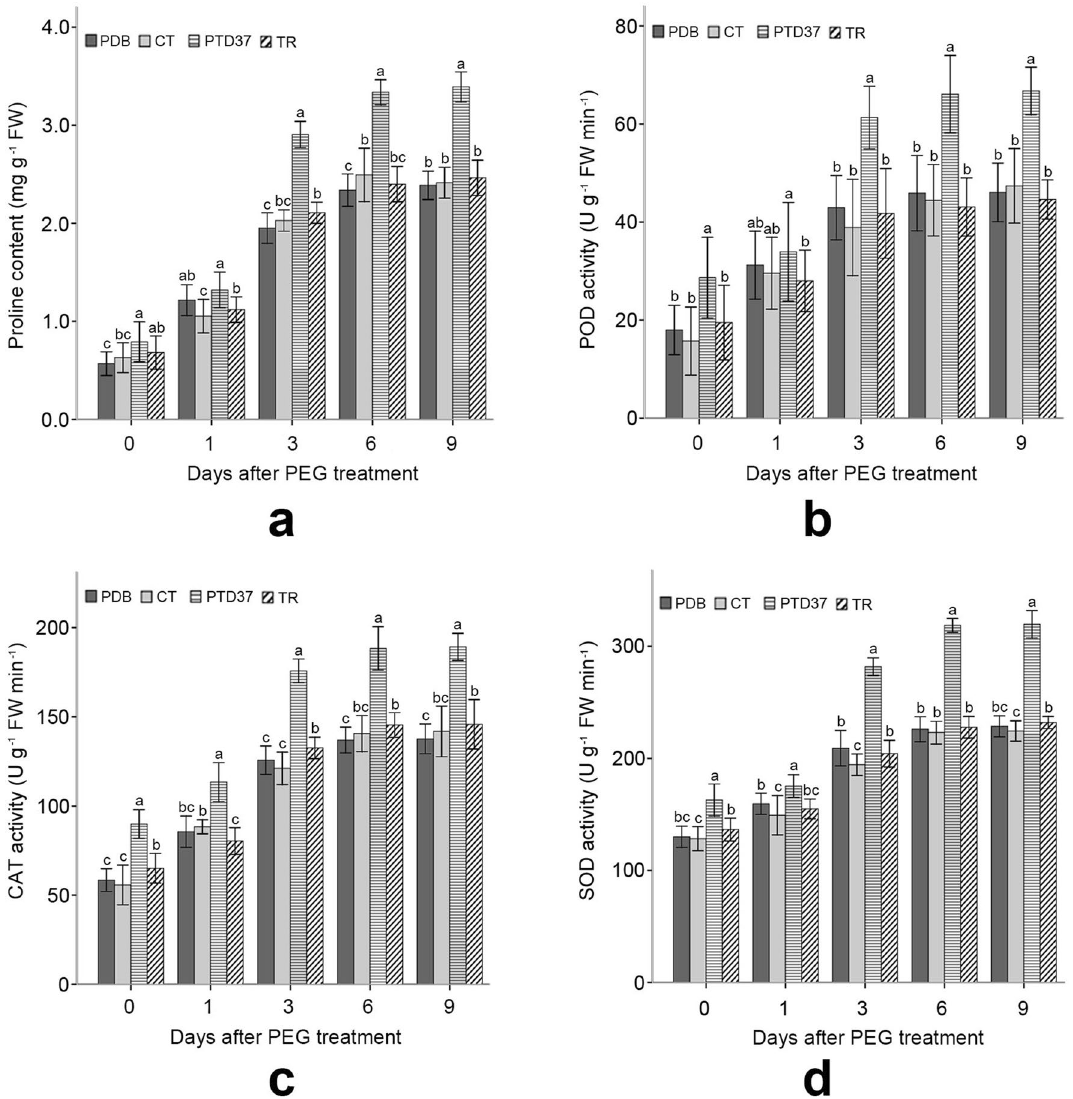
Figure 3. Effect of different treatments on the proline content and POD, CAT and SOD activities of seedling leaves before and after PEG application. ( a ) Effect of PEG application on the leaf proline content of seedlings under different treatments. ( b ) Effect of PEG application on the leaf POD activity of seedlings under different treatments. ( c ) Effect of PEG application on the leaf CAT activity of seedlings under different treatments. (d) Effect of PEG application on the leaf SOD activity of seedlings under different treatments. CT = control; PDB = potato dextrose broth; PTD37 = fermentation broth supernatant of the PTD37 strain; TR = fermentation broth supernatant of T. harzianum . Data are the means ± SD from five independent tests. Different letters on error bars indicate significant differences at P = 0.05 between analyzed traits of seedlings from different treatments on the same day after PEG application. The values on day 0 after PEG treatment indicate that they were measured before PEG